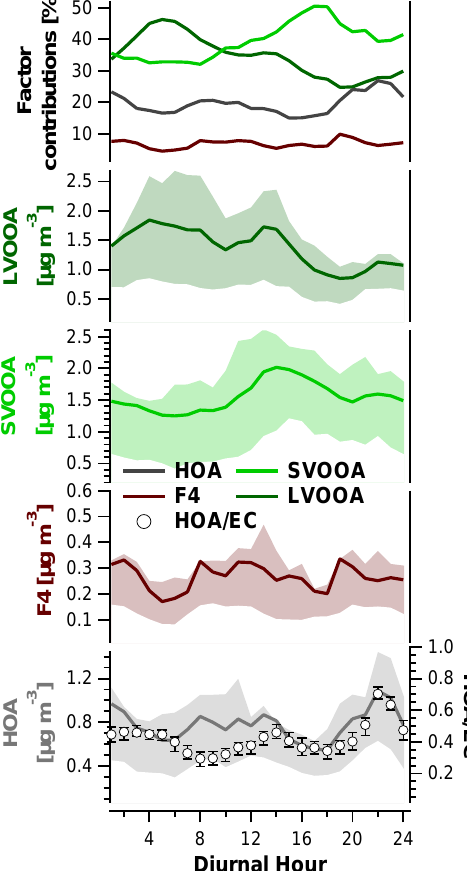
Fig.4: Diurnal profiles of AMS/PMF2 factors. Solid 1121 Fig. 4. Diurnal profiles of AMS/PMF2 factors. Solid lines denote lines denote average profiles and dashed areas denote 1122 P25-P75 ranges. The HOA/EC ratio and the factors 1123 average profiles and dashed areas denote P25–P75 ranges. The relative contributions to OA are also shown in the lower 1124 HOA/EC ratio and the factors relative contributions to OA are also and upper panels, respectively. 1125 shown in the lower and upper panels, 1126